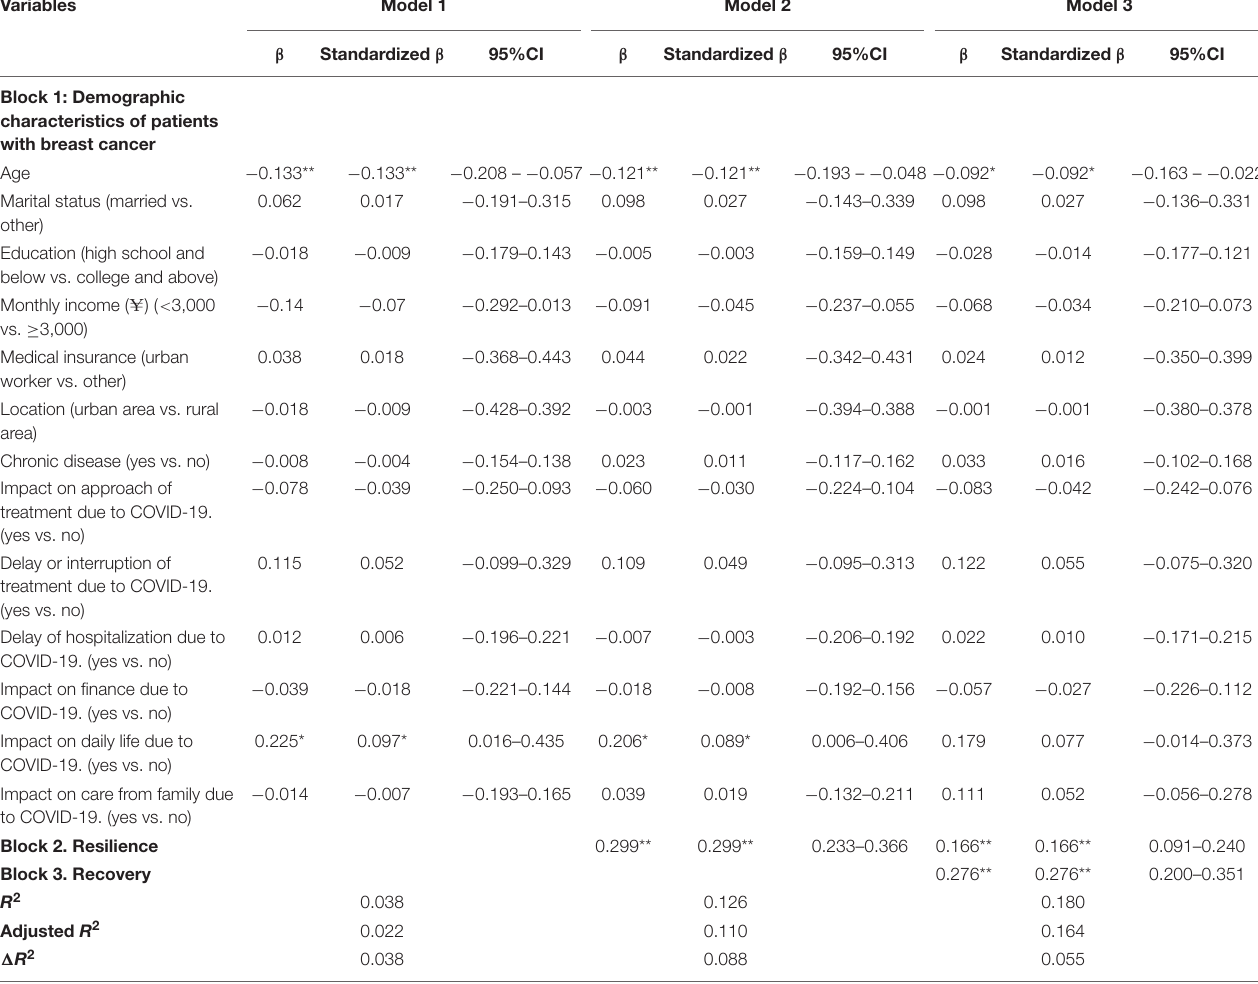
TABLE 3 | Associated factors of PTG during the COVID-19